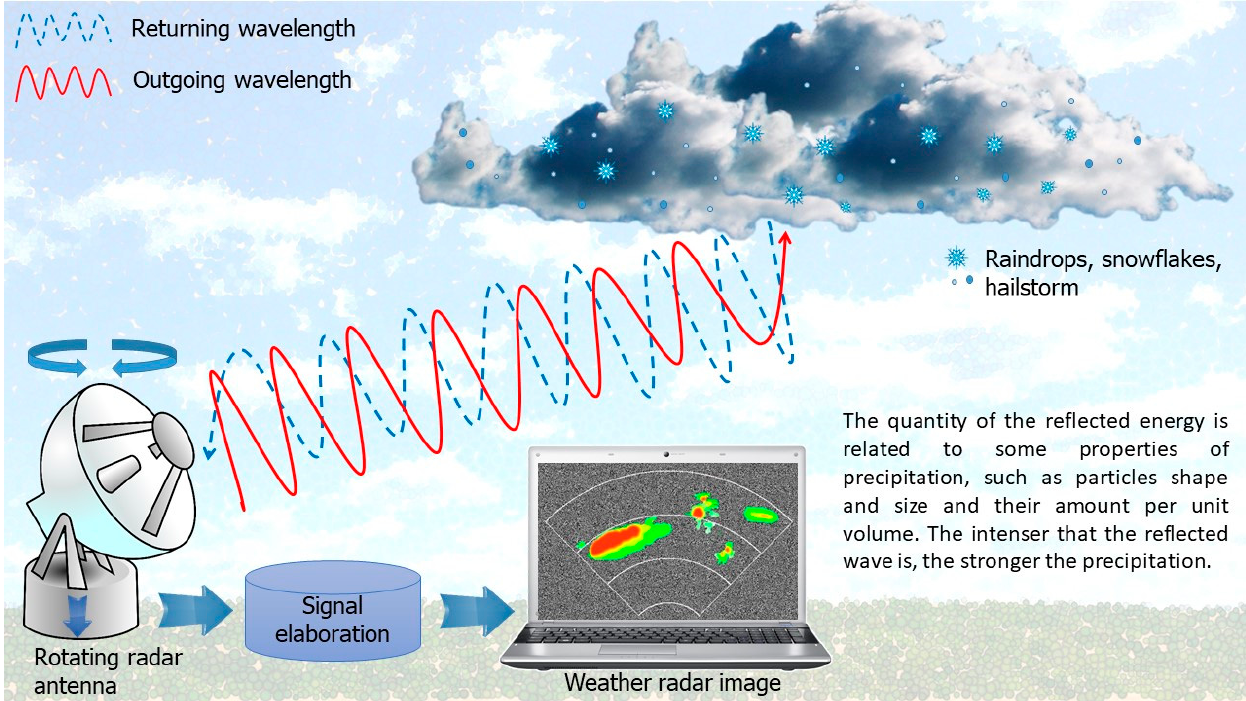
Figure 1. Weather radar principle of function. Weather radar image reworked from source